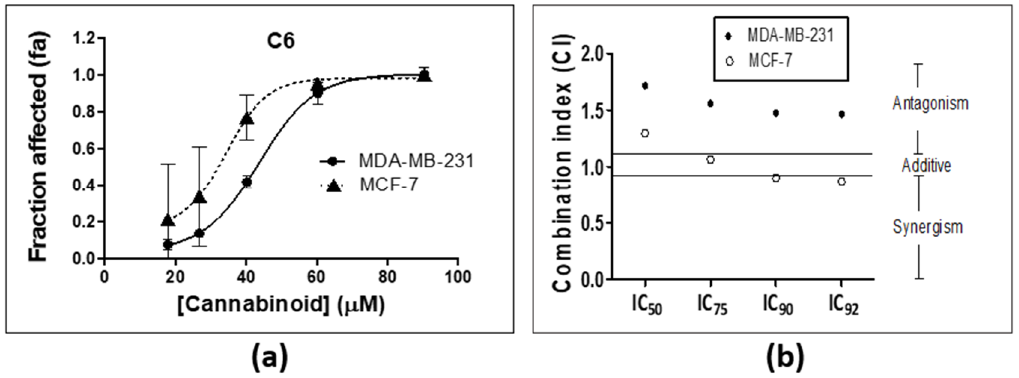
Figure 4. Evaluating the efficacy of C6 across two breast cancer cell lines. ( a ) Dose response curves of C6 in the MDA-MB-231 and MCF-7 cell lines, ( b ) CI value of C6 determined at the selected percentages of growth inhibition in the MDA-MB-231 and MCF-7 cell lines.